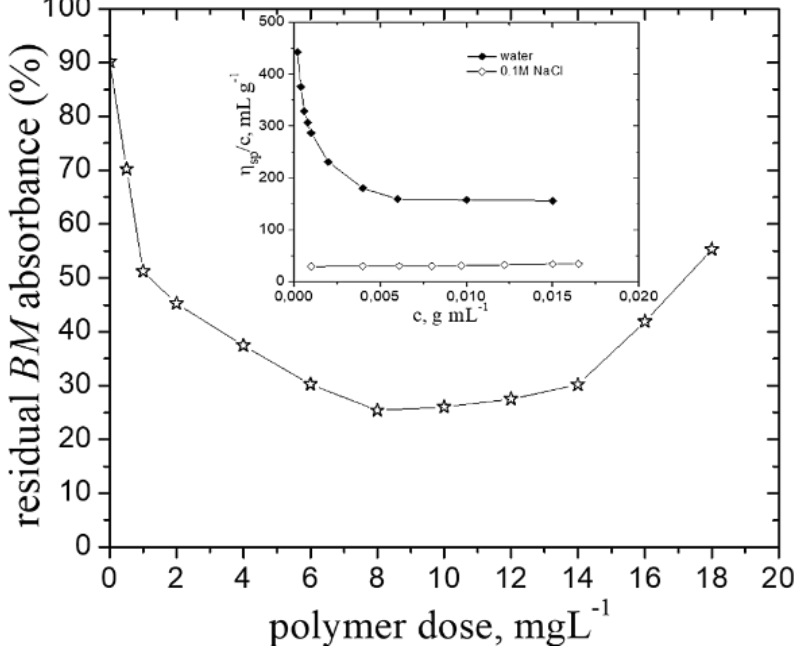
Figure 3. The residual BM absorbance (%) dependence on the polymer dose (salt solution of P ₋ g ₋ pAPTAC2 in 0.1M NaCl); c BM (%, w/w ) - 0.05, settling time 60 min. The inset: the reduced vis- pAPTAC2 in 0.1 M NaCl); c BM (%, w / w )—0.05, settling time 60 min. The inset: the reduced viscosity cosity dependence on polymer concentration, c . dependence on polymer concentration, c